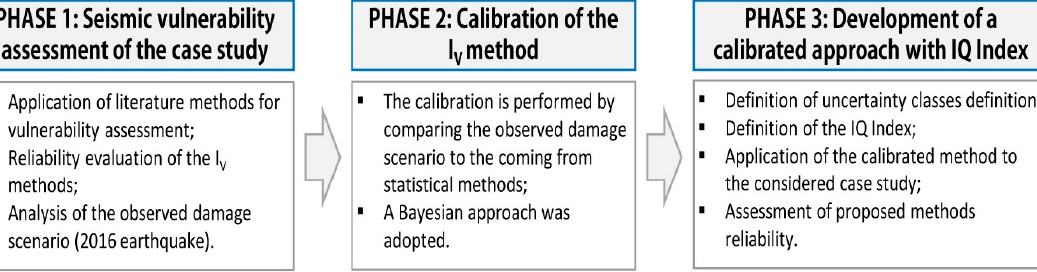
Figure 1. Methodological framework adopted in the present work.